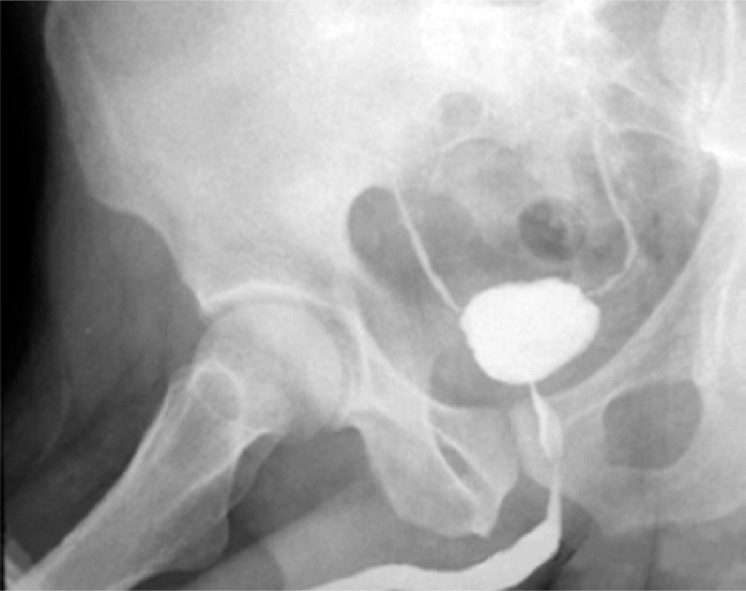
Uretrocistografia. Bexiga de pequena capacidade, refluxo vesicureteral bilateral grau I e resíduo pós-miccional